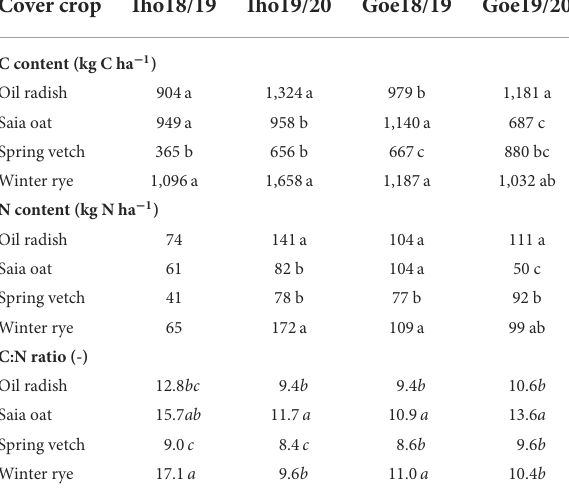
TABLE 2 C and N content and C:N ratio of aboveground biomass of four cover crops in late autumn at Iho18/19 and 19/20, and Goe18/19 and 19/20.